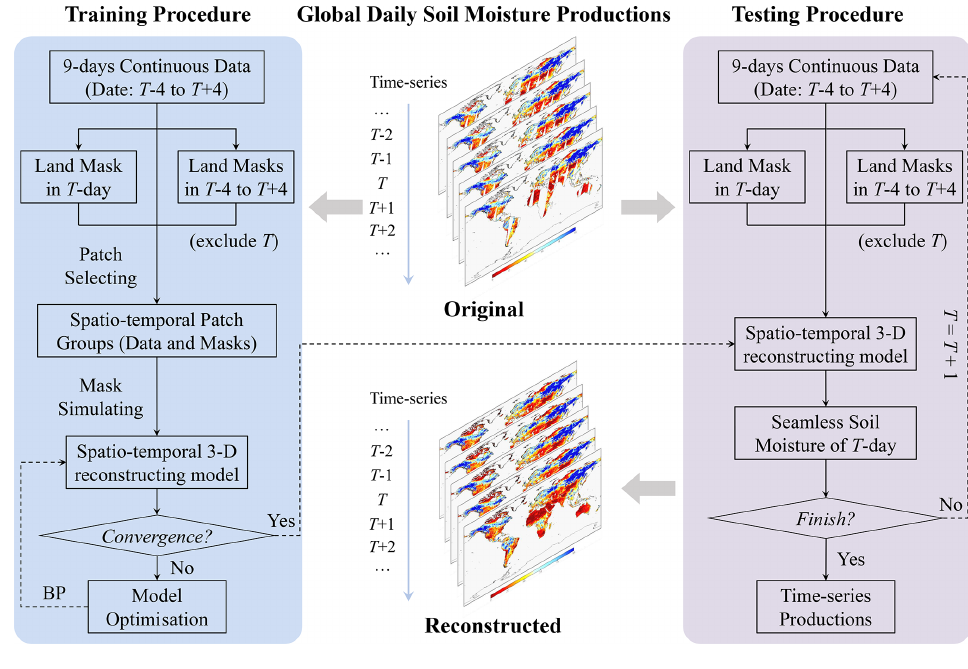
Figure 3. Flow chart of the presented framework.